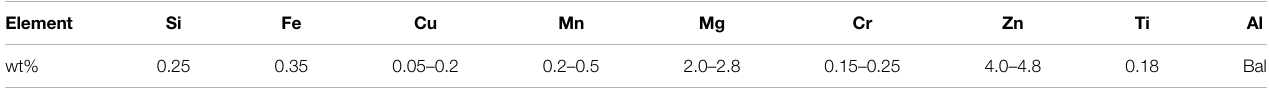
TABLE 1 | Main chemical composition of 7A52 aluminum alloy.